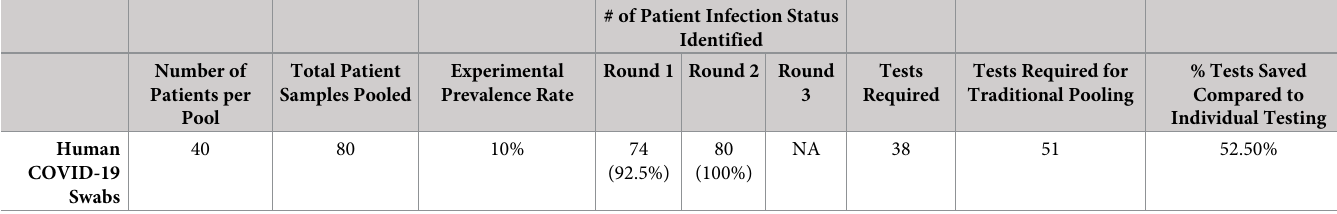
Table 4. Compressed sensing decoded pooled testing accurately identifies positive human COVID-19 samples at real world prevalence